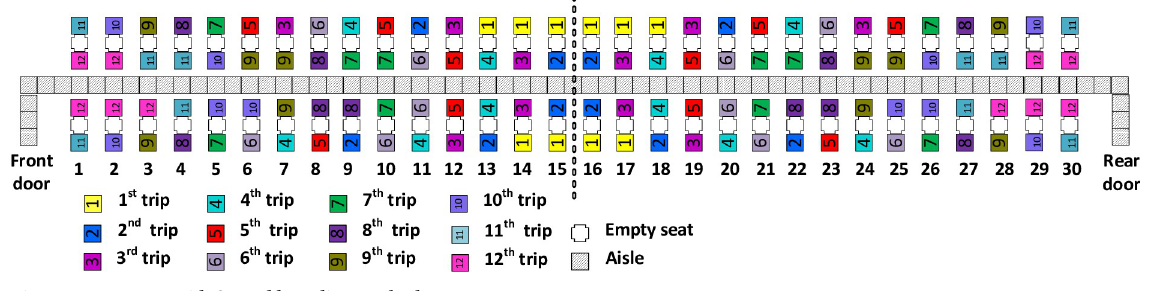
Fig 6. Reverse-pyramid–Spread boarding